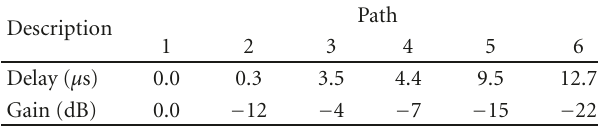
Table 2: “Brazil B” channel multipath profile.